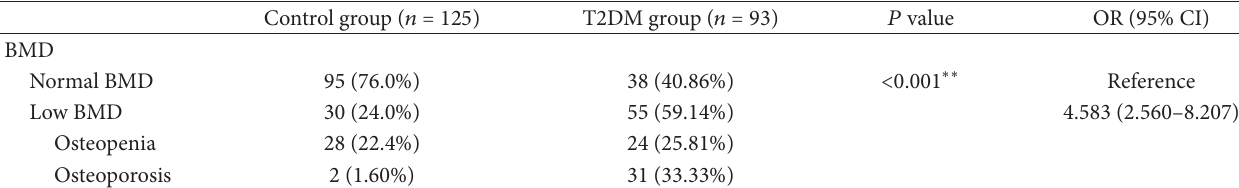
T 2: Prevalence of osteoporosis in patients with T2DM and control